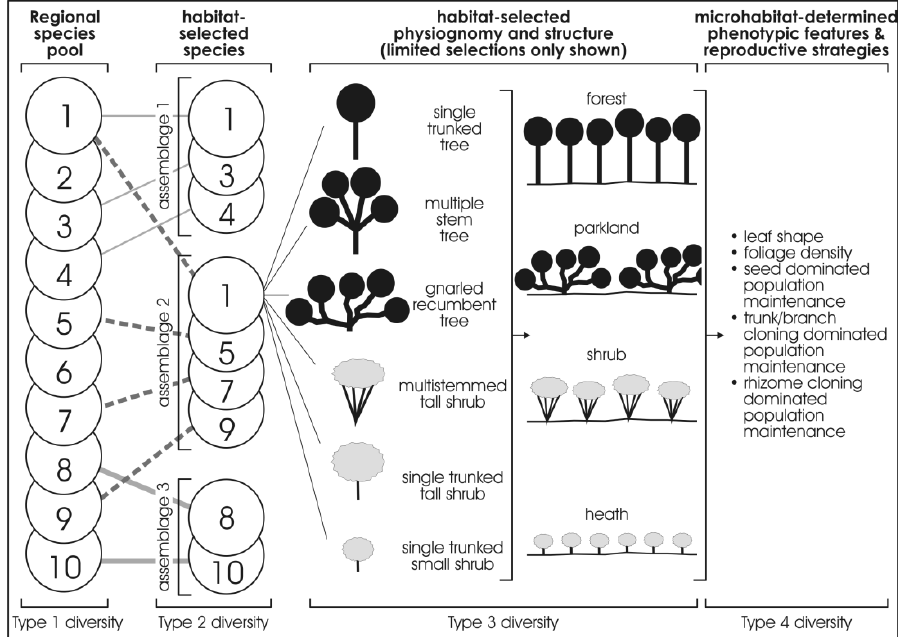
Figure 3. Idealised diagram showing progressive selection from the regional species pool (the species numbers used in the regional species pool amount to ten, but it could be 100 species or 1000 species), a range of habitat-selected species which, in turn, progressively are selected as to physiognomy, other phenotypic expressions, and vegetation